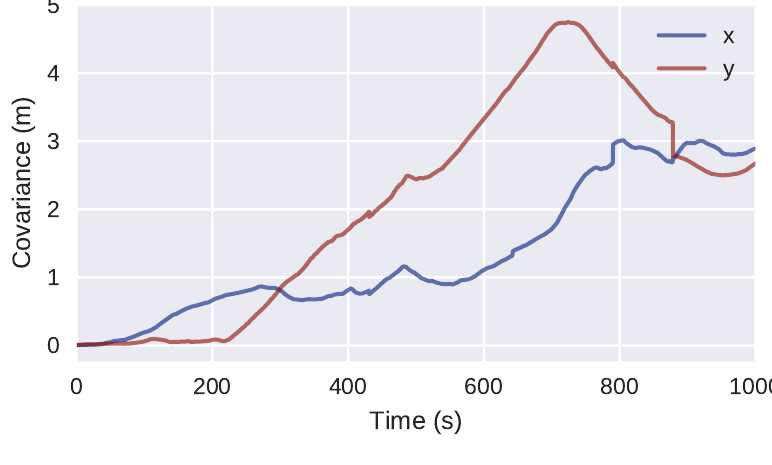
Figure 21. Covariance of the particles over time for the Rocks dataset.